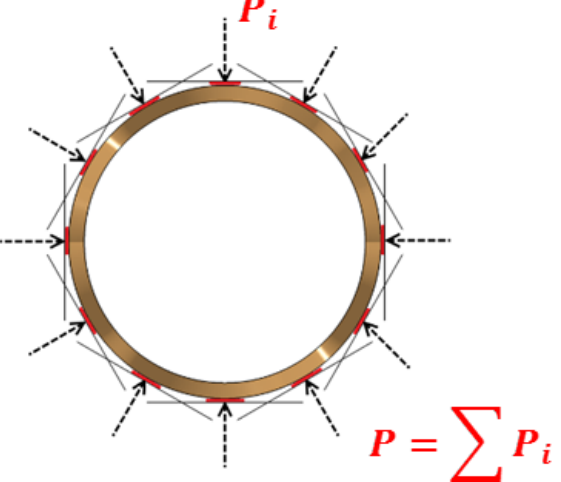
Figure 6. Boundary conditions for free stent compression: front view of the displacement of 12 predefined rigid wall structures (shown in black).